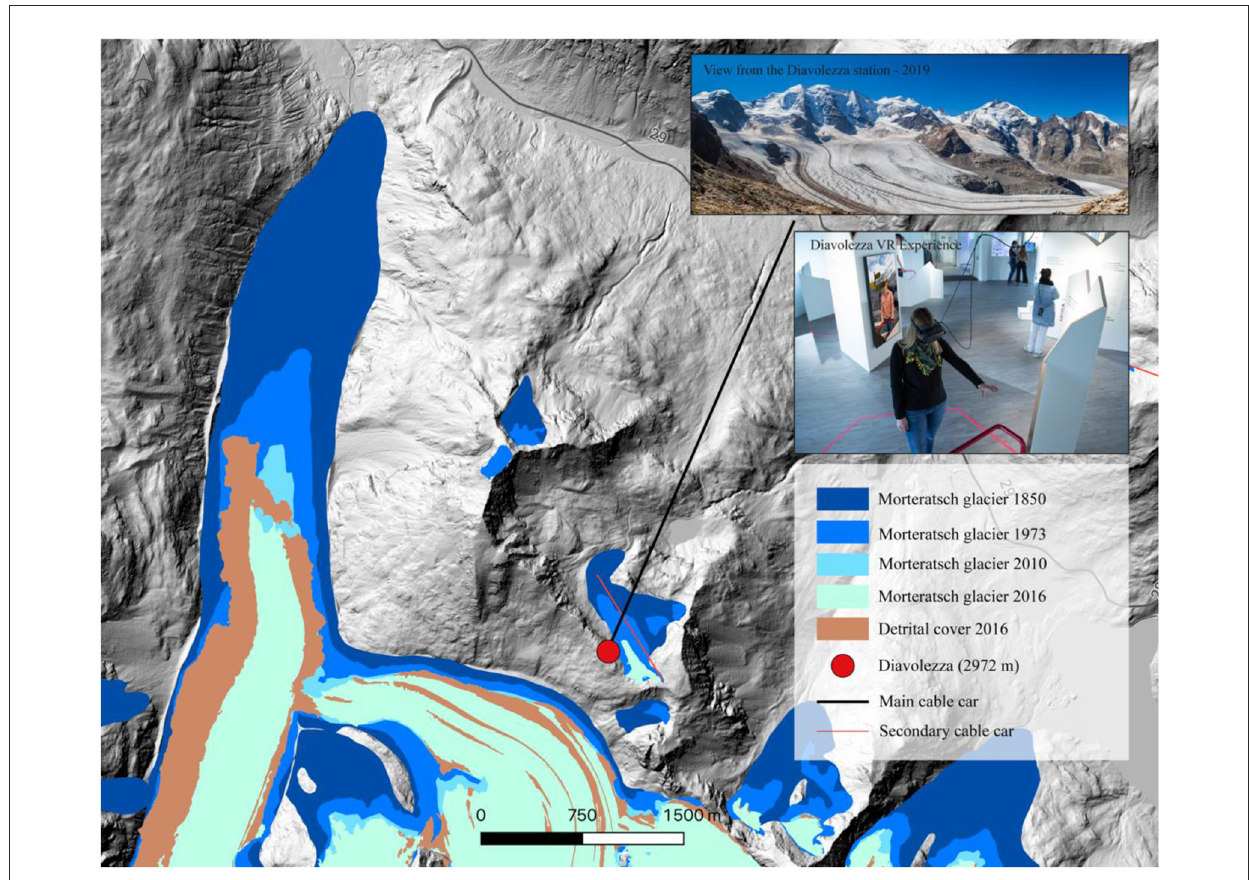
FIGURE3 Evolving state of the Diavolezza site and the Morteratsch Glacier. The glacier extensions are based on GLAMOS-Glacier Monitoring Switzerland (2019). Pictures of the Diavolezza Glacier VR Experience room were taken by Peter Stein